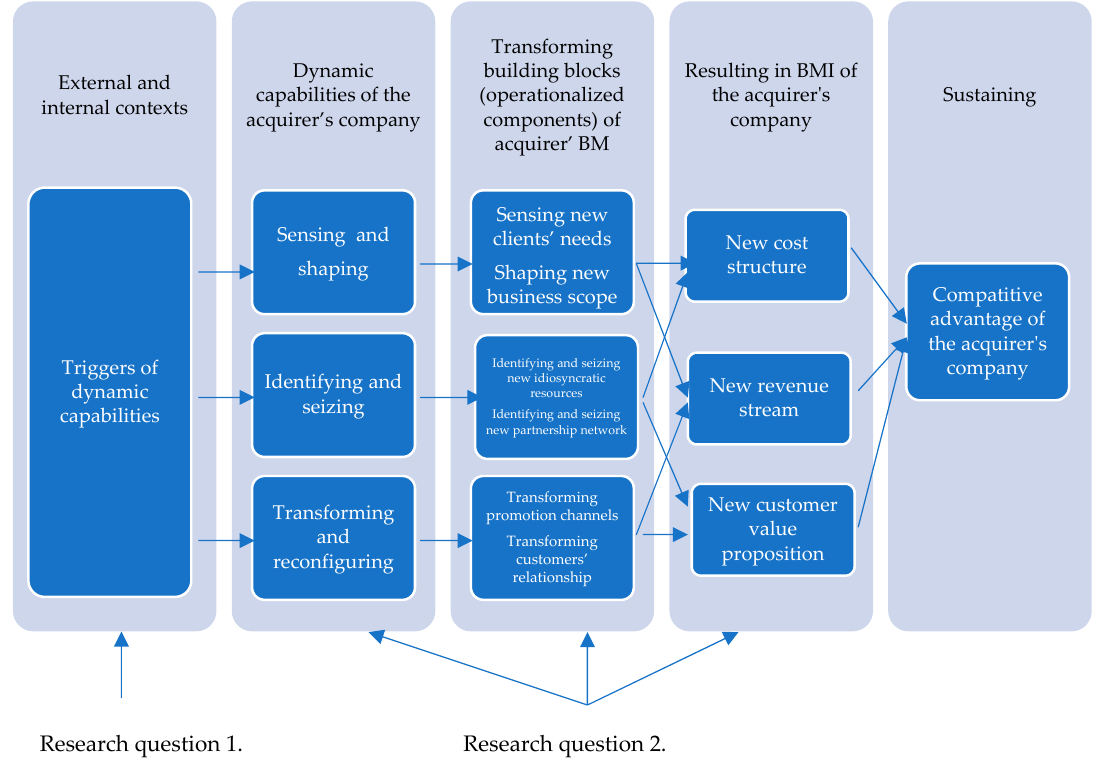
Figure 1. The conceptual model of current research (Source: developed by author).